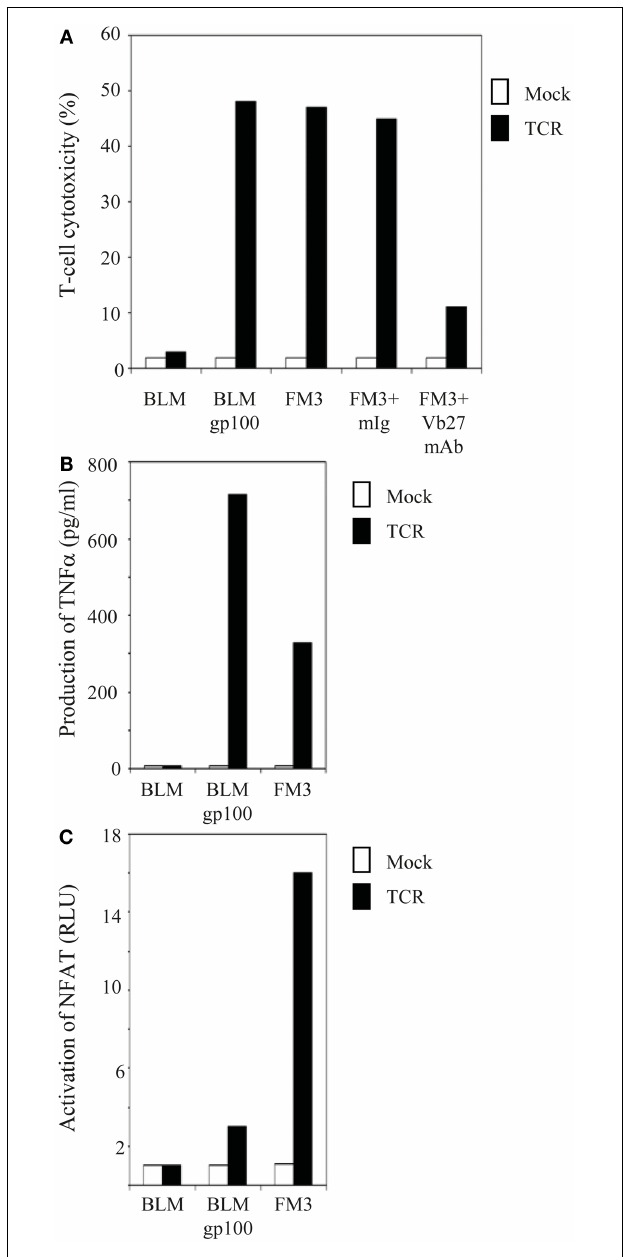
FIGURE 1 |T cells gene-engineered with a gp100/HLA-A2-specificTCR demonstrate antigen-specific reactivity against melanoma cells . (A) TCR-transduced humanT cells lyse gp100-positive, HLA-A2-positive melanoma cells. Primary humanT cells transduced withTCR (black bars) or Mock genes (white bars) were tested in a 6h 51 Cr-release assay with the following target cells: the gp100-negative, HLA-A2-positive melanoma cell line BLM and the gp100-positive, HLA-A2-positive melanoma cell lines BLMgp100 and FM3.The effector to target cell ratio was 30:1. Inhibition studies were performed withT cells and FM3 target cells using anti-TCRV β 27 mAb (Vb27) or mIg. Specific lysis was calculated, and results of one (out of three) representative experiment are shown. (B) TCR-transduced humanT cells produceTNF α in response